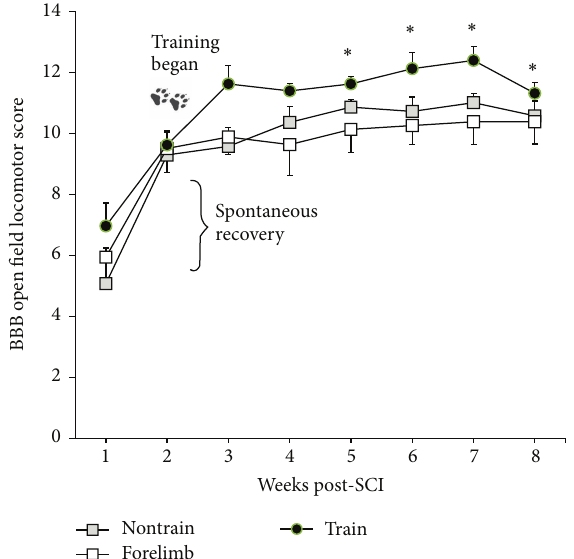
Figure 1: Weekly open field locomotor scoring of trained, non- trained, and forelimb SCI male rats. Statistically significant loco- motor recovery occurred from week 1 to week 2 for all groups. At 2 weeks post-SCI training began. Only the trained group had significant increases from pretraining. Shams not shown, BBB = 21 ( ∗ versus pretraining; W2; repeated ANOVA with Bonferroni post hoc 𝑡 -tests: nontrain 𝑛 = 7 ; forelimb 𝑛 = 9 ; train 𝑛 = 13 ).